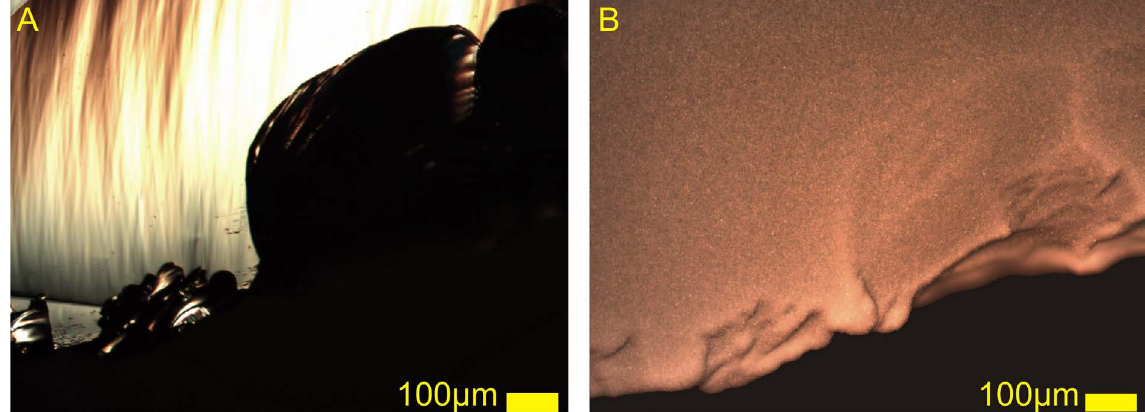
Figure 10. The same point on an experimental tool used for cutting bone at 100x; A. Area without magnesium in which it is possible to distinguish microchipping and striations; B. With the magnesium coat it is impossible to see the striations, and the morphology of the microchipping is